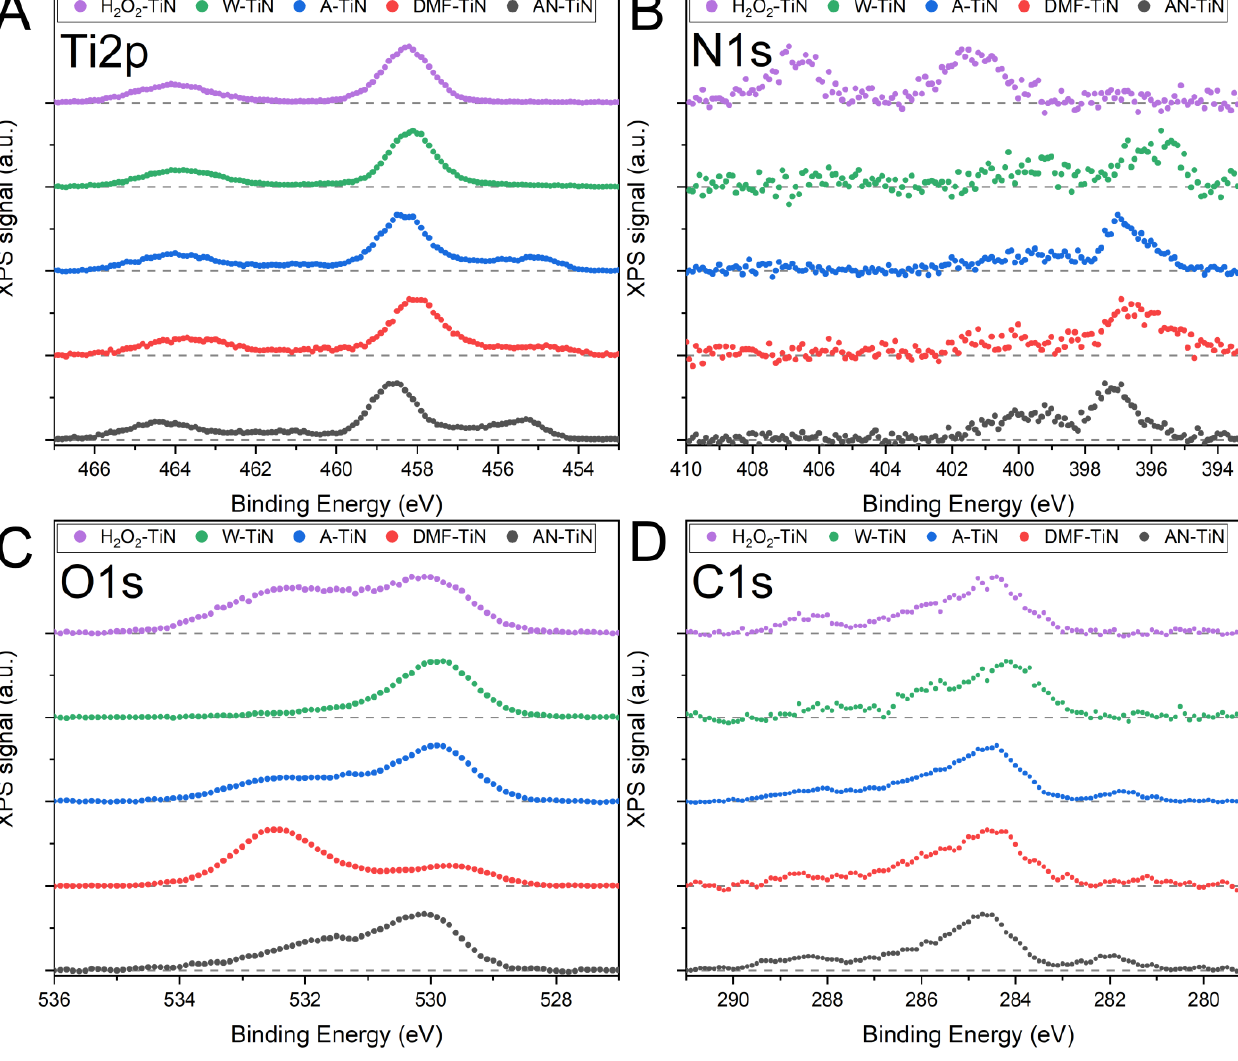
Figure 3. XPS characterization of the synthesized NPs. ( A ) Ti 2p, ( B ) N 1s, ( C ) O 1s, and ( D ) C 1s electronic levels of H 2 O 2 -TiN (purple), W-TiN (green), A-TiN (blue), DMF-TiN (red), and AN-TiN (black) NPs.